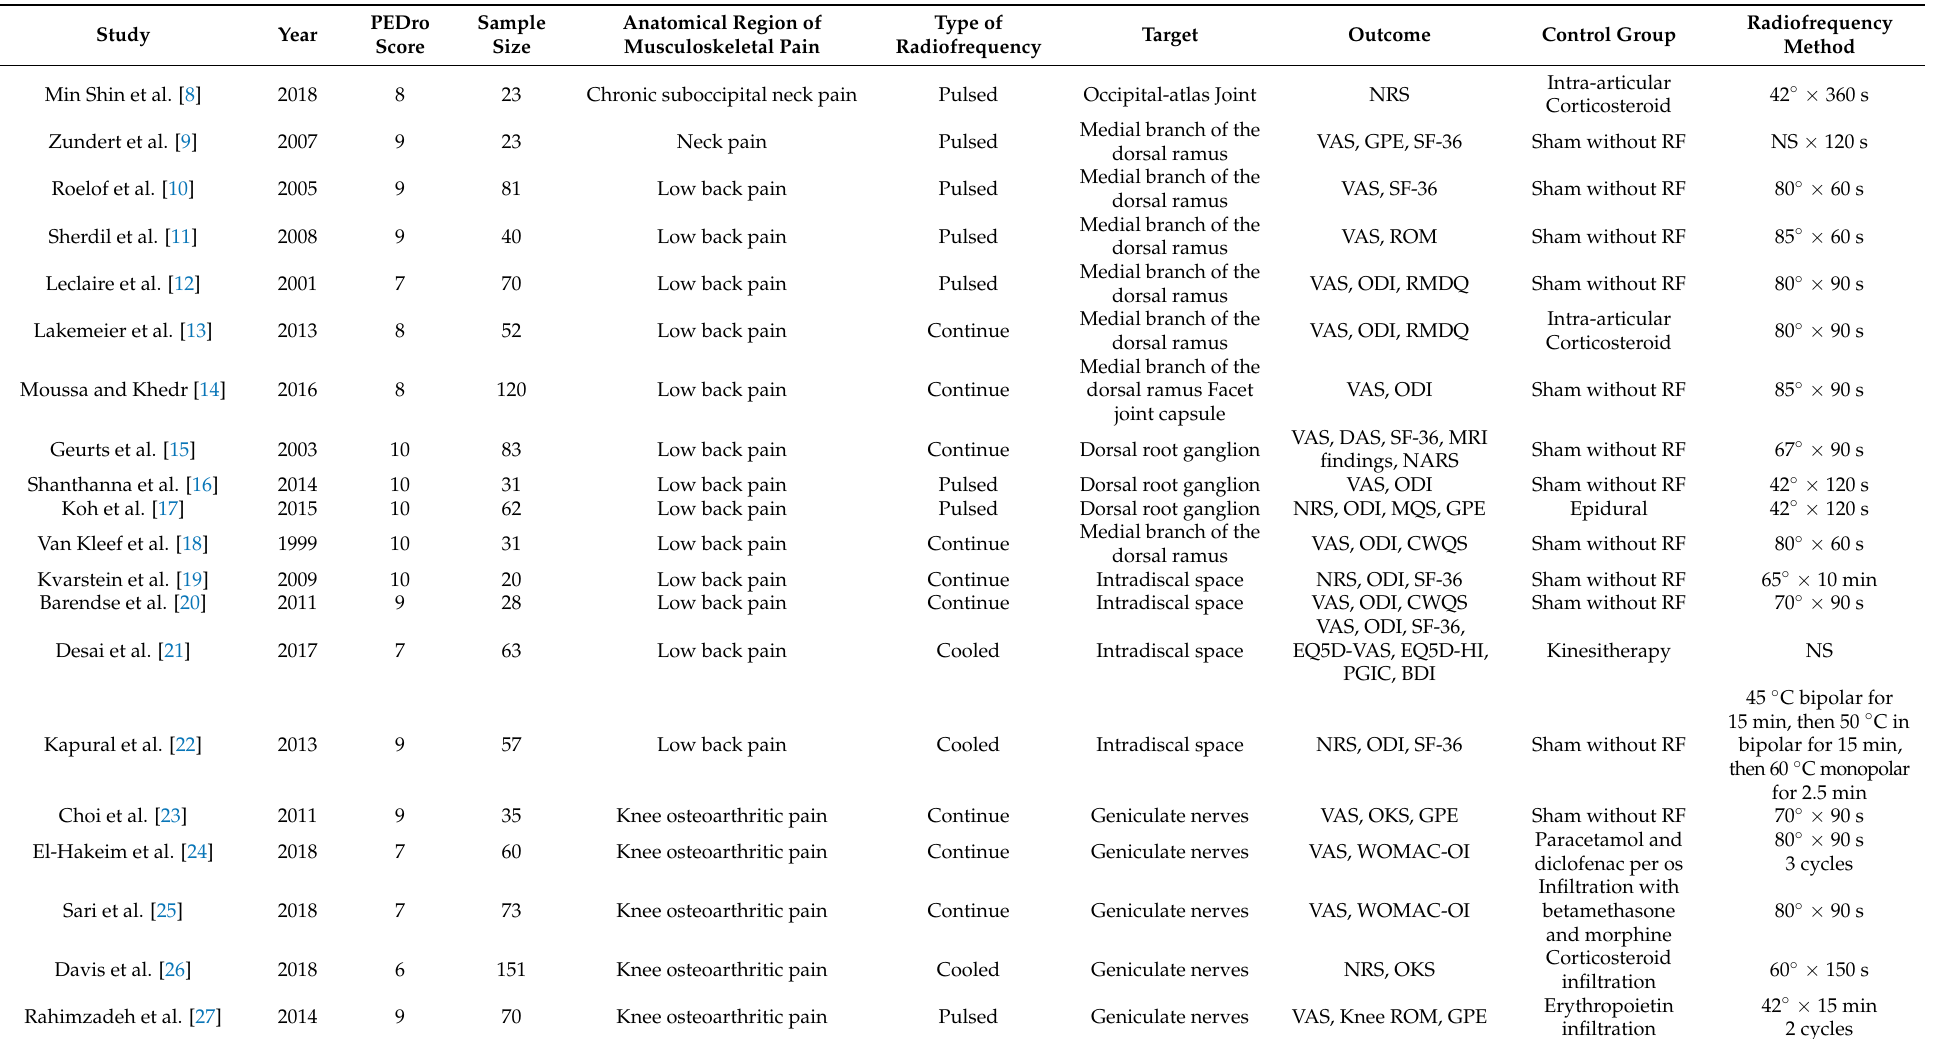
Table 1. Main characteristics of the studies